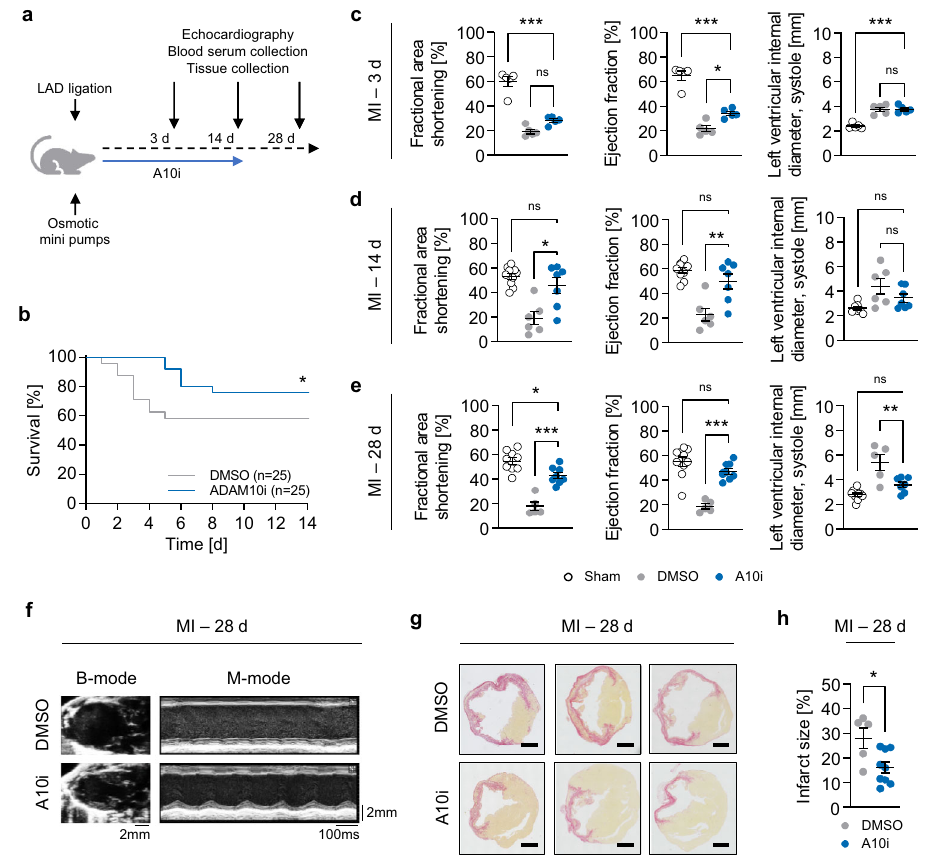
n =5), d 14 days (Sham, n =10.DMSO, n =6.A10i, n =7)and e 28days (Sham, n =9. DMSO, n =5. A10i, n =8) after myocardial infarction (mean±SEM, * P